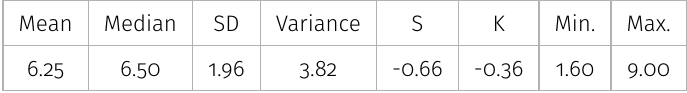
Table IV. Descriptive statistics for turbochargers